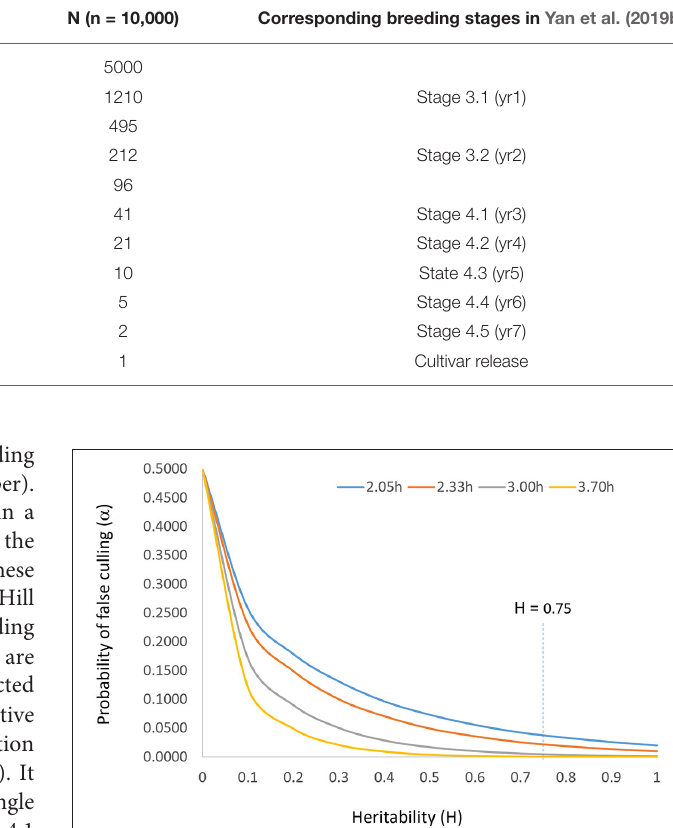
ih ), the proportion of the population to be retained ( α ), and the number of genotypes to be retained ( N ) at different levels of = 10,000 and a selection intensity of i =